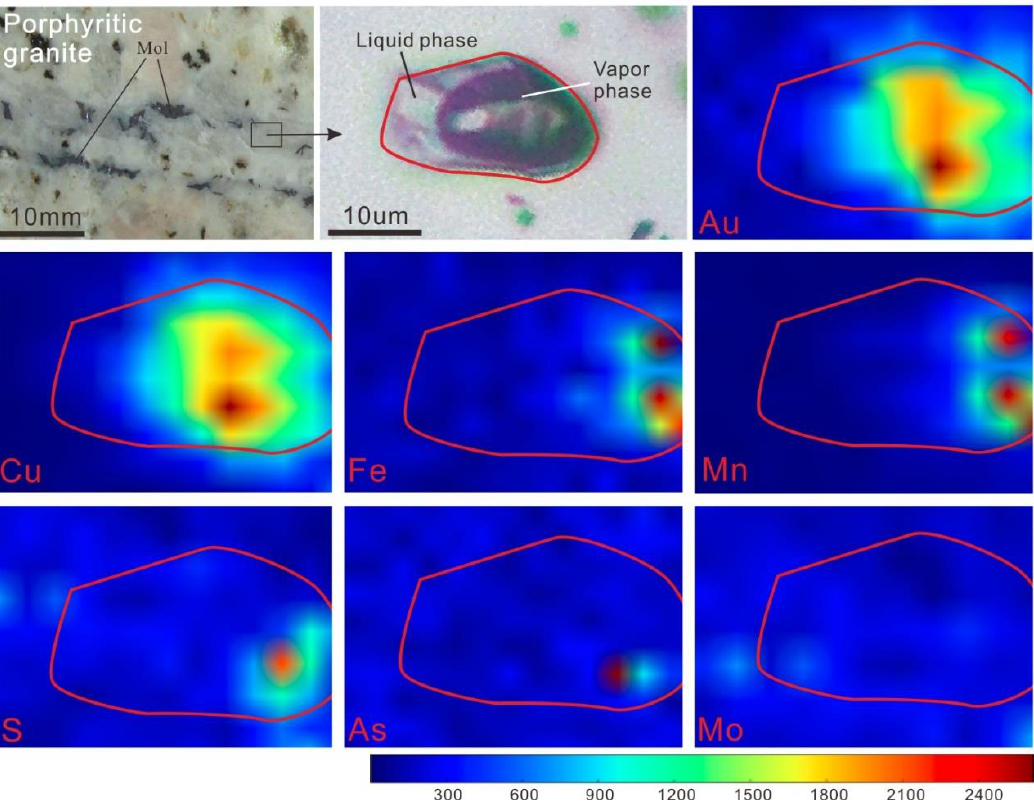
Figure 9. Trace element enrichment maps of a single fluid inclusion in an Mo-bearing vein from the porphyritic granite.